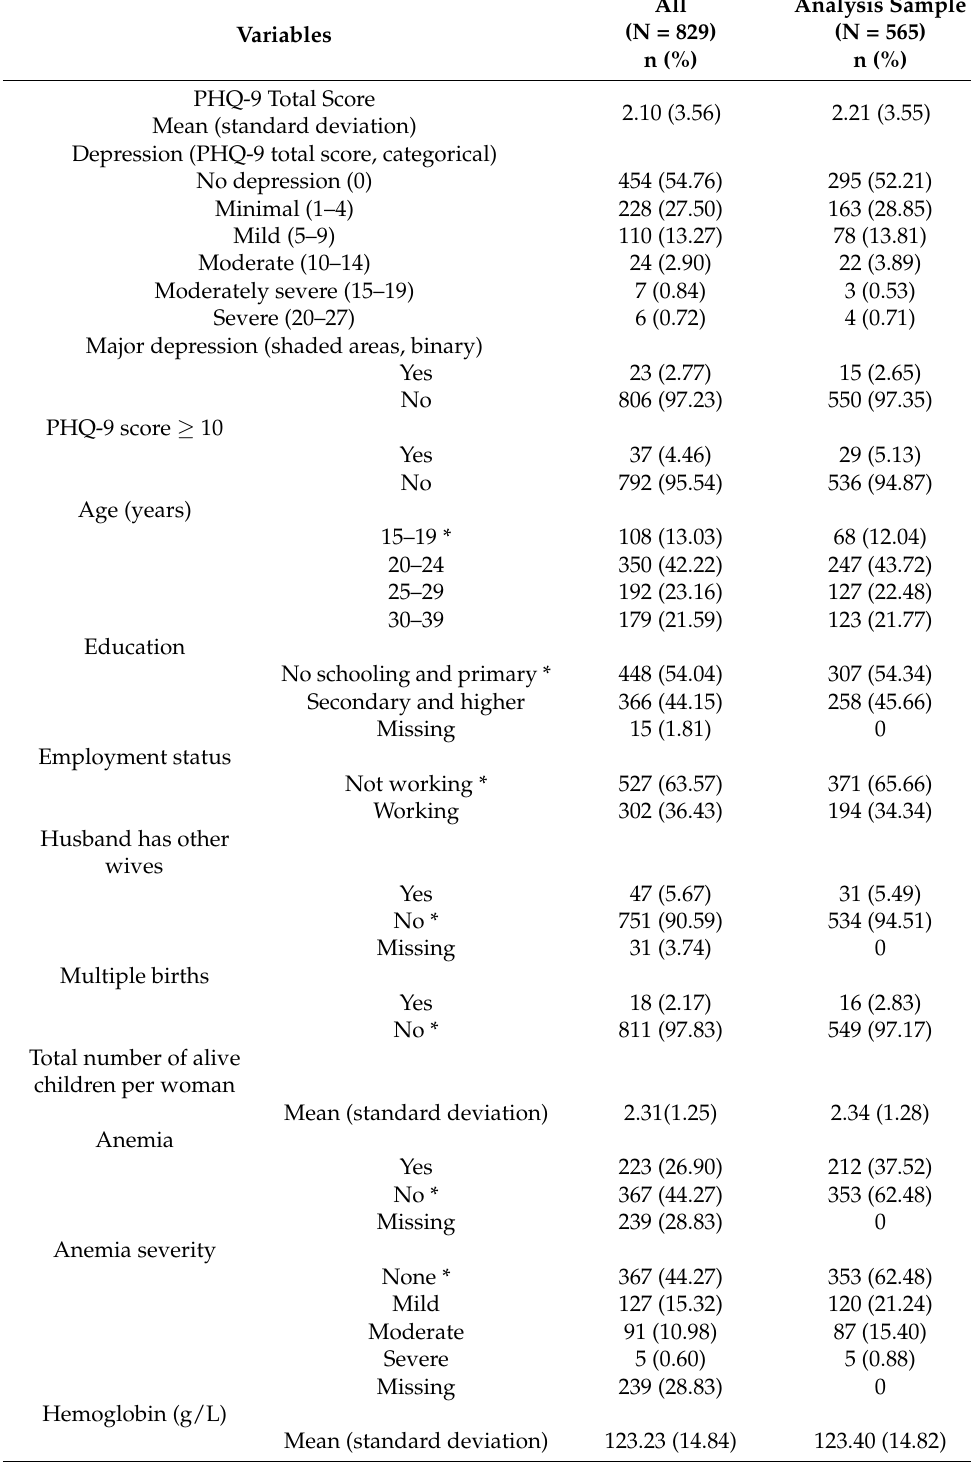
Table 1. Descriptive Statistics of total sample and analytic